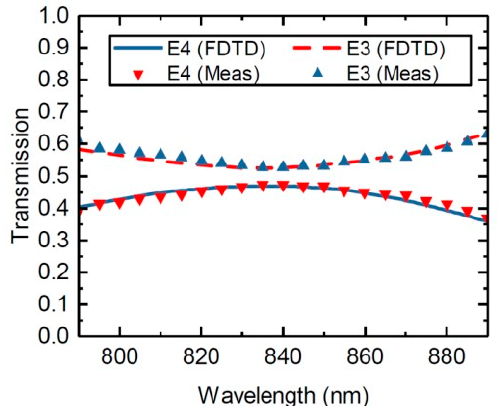
Figure 3. Measured results and predicted values by 3D FDTD simulations for the wavelength dependence of the splitting ratio of a broadband 2 × 2 coupler designed for 50:50 splitting ratio at 840 nm (TE-like